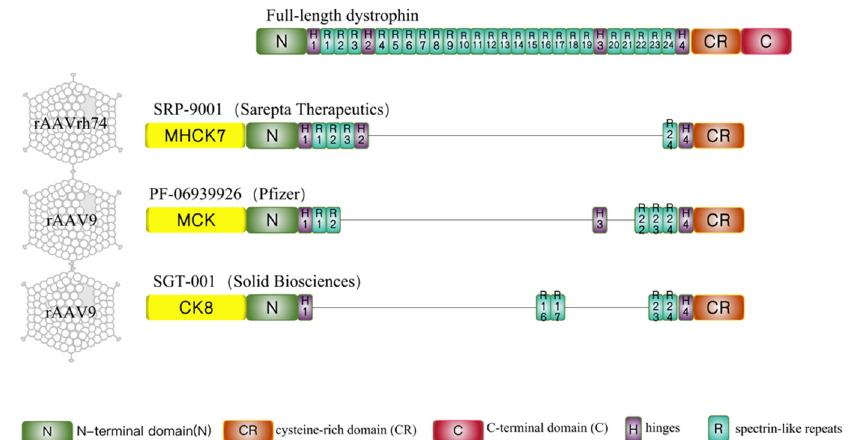
Figure 1. Full-length dystrophin and micro-dystrophins designed in 3 clinical trials. Full-length dystrophin contains an N-terminal domain (N), 24 spectrin-like repeats (R1 to R24), four hinges Table 1. Current status of systemic AAV mini/micro-dystrophin clinical trials.